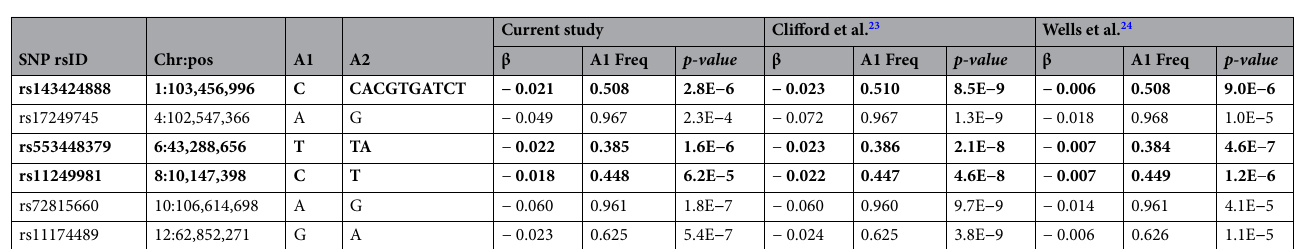
Table 5. The summary statistics for the top SNPs associated with tinnitus by Wells et al. 24 and Clifford et al. 23 . Significant values are in bold. rs143424888, rs553448379, and rs11249981 were replicated in the Million Veteran Program sample by Clifford et al. 23 . SNP rsID presents the rsID of the single nucleotide polymorphism (SNP). Chr:por presents the chromosomal number and position of SNP, A1 is the frequency is of A1 allele, and A2 is the frequency of A2 allele, beta presents the regression correlation coefficient, and p-value presents the observed p-value of the regression